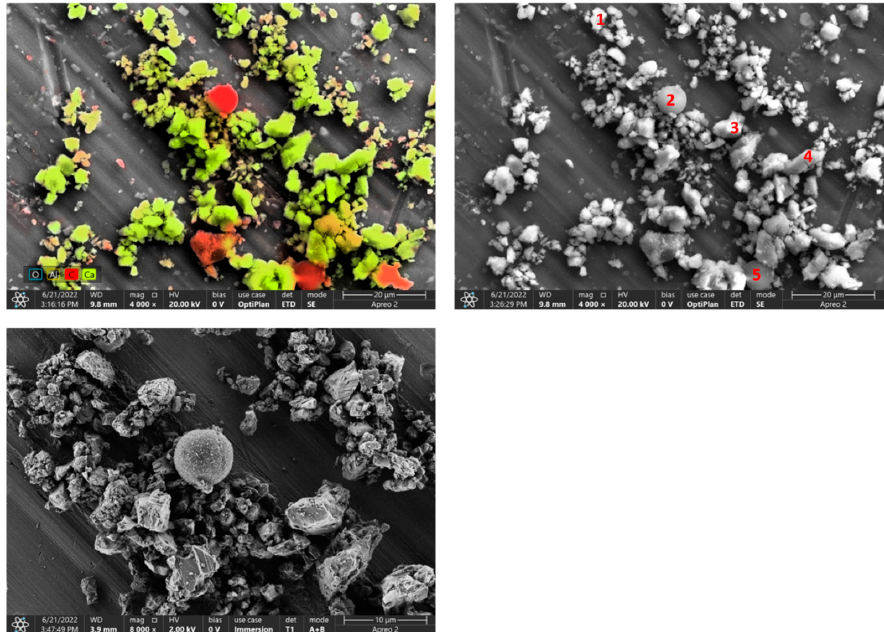
Figure 5. SEM-photographs and EDS analysis of sample B of calcite contaminated with waste toner powder (red numbers mark EDS analysis points). Table 3. Results of EDS analysis of sample B.